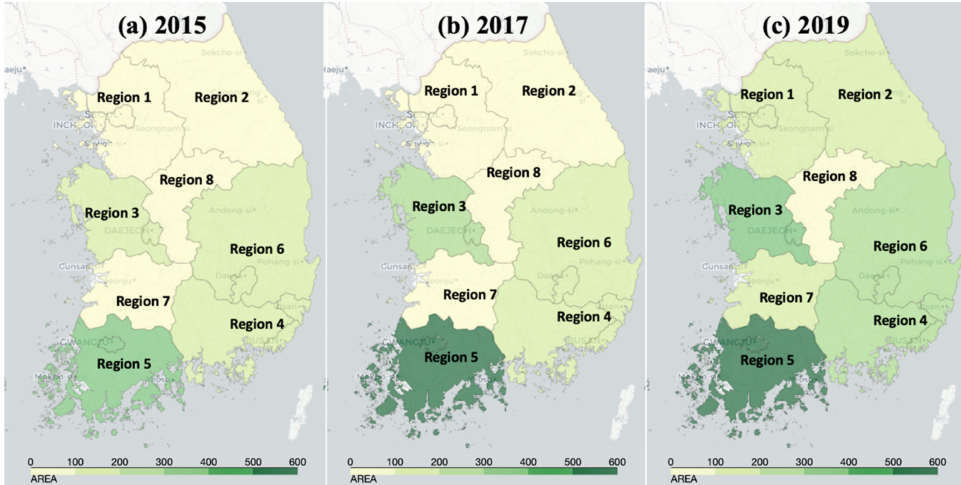
Figure 11. Differences in regional PPA capacity and changes by year.